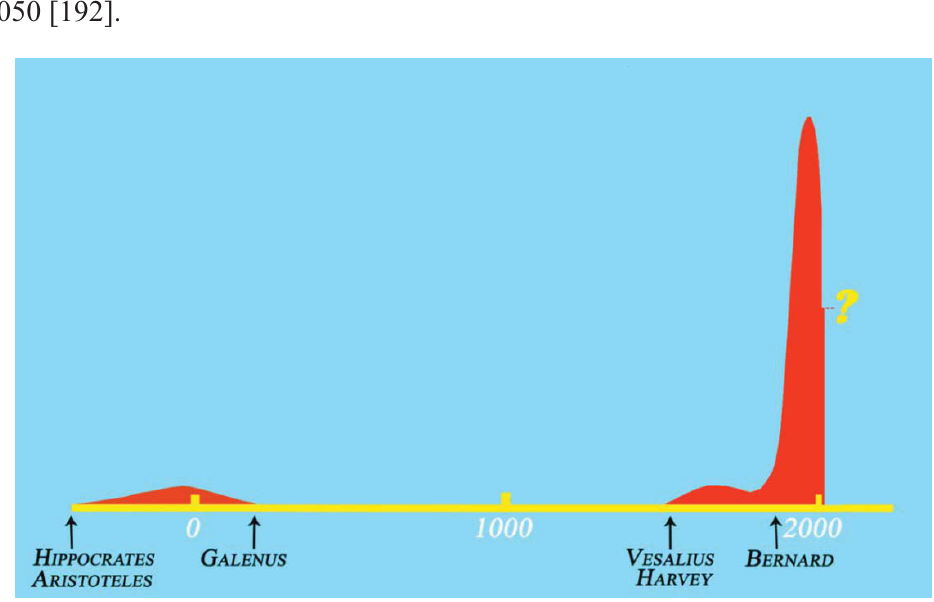
Figure 7. This schematic illustration (adapted with permission from an original by Professor Bert van Zupthen) attempts to describe trends in the use of animals for scientific purposes in the Western world across time. It depicts the emergence of the first vivisection studies by classical Greek physicians, the absence of animal-based research—along with most medical and scientific research—across the Middle Ages, its resurgence in the Renaissance onwards, and the rapid increase in animal studies following the rise of science-based physiology and medicine in the nineteenth century. The curves represented are nevertheless conjectural, as there are no reliable statistics on animal use for most of the period covered. Even nowadays it is hard to estimate trends in animal research, as data from several developed countries is insufficient (for instance, in the United States, rodents, fish and birds are not accounted for in the statistics). The available data, however, suggest that the number of animals used in research and testing in the Western world peaked in the 1970s, and decreased until the late 1990s, or early 2000s, to about half the number of 30 years earlier, and stabilizing in recent years. While many, if not most, researchers do not foresee an end to animal experiments in biomedicine, the European Commission has nevertheless set full replacement of animal experiments as an ultimate goal [204], and the Humane Society of the United States has the optimistic goal of full replacement by the year 2050